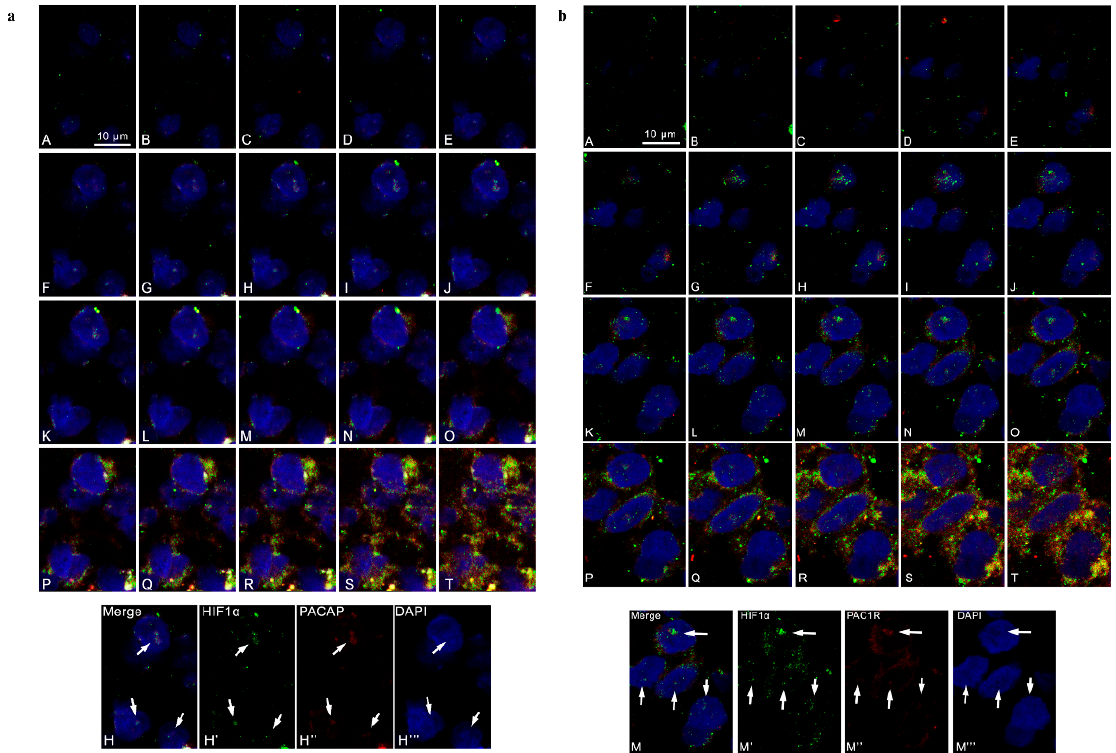
Figure 2. Cellular co-localization of PACAP, PAC1R and HIF-1 α in human GBM serial sections. Representative photomicrographs showing the cellular co-localization of HIF-1 α and PACAP or PAC1R. ( a ) Green, red and blue correspond to HIF-1 α , PACAP and DAPI respectively. H’, H” and H”’ in the panel c show the red, green and blue channels corresponding to a section positioned in the middle part of the z axis. The white arrows indicate the co-localization of HIF-1 α and PACAP in the cell nuclei. Scale bar is 10 µ m. ( b ) Green, red and blue correspond to HIF1 α , PAC1R and DAPI respectively. M’, M” and M”’, in the panel d, show the red, green and blue channels corresponding to a section positioned in the middle part of the z axis. The white arrows indicate the co-localization of HIF1 α and PAC1R in the cell nuclei. Scale bar is 10 μ m.